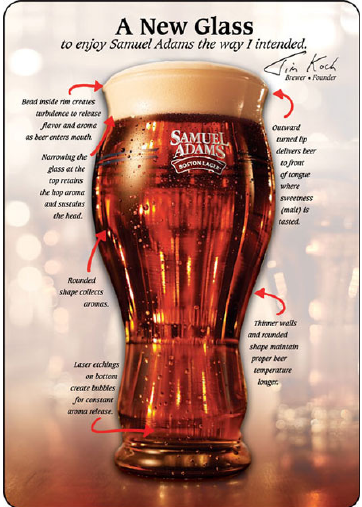
Figure 5. The Samual Adams “Perfect Pint Glass”. Reproduced from [66].